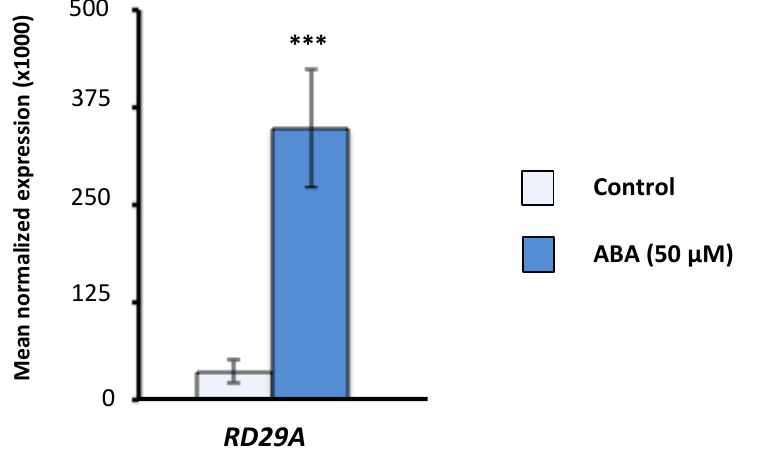
Figure 1. Effect of the abscisic acid (ABA) treatment on RD29A gene expression. Real-time RT-qPCR analysis of total transcript levels of the ABA-responsive gene RD29A in control and ABA-treated (50 µM for 5 h) Arabidopsis seedlings. Results are from two independent experiments and values represent means ± SE ( n = 4). Asterisks indicate a significant difference (*** p < 0.001; Student’s t -test) from control